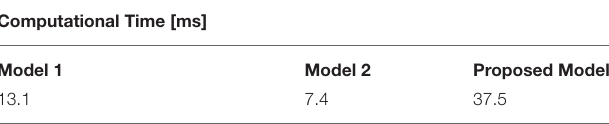
TABLE 4 | Computational time of different decoding